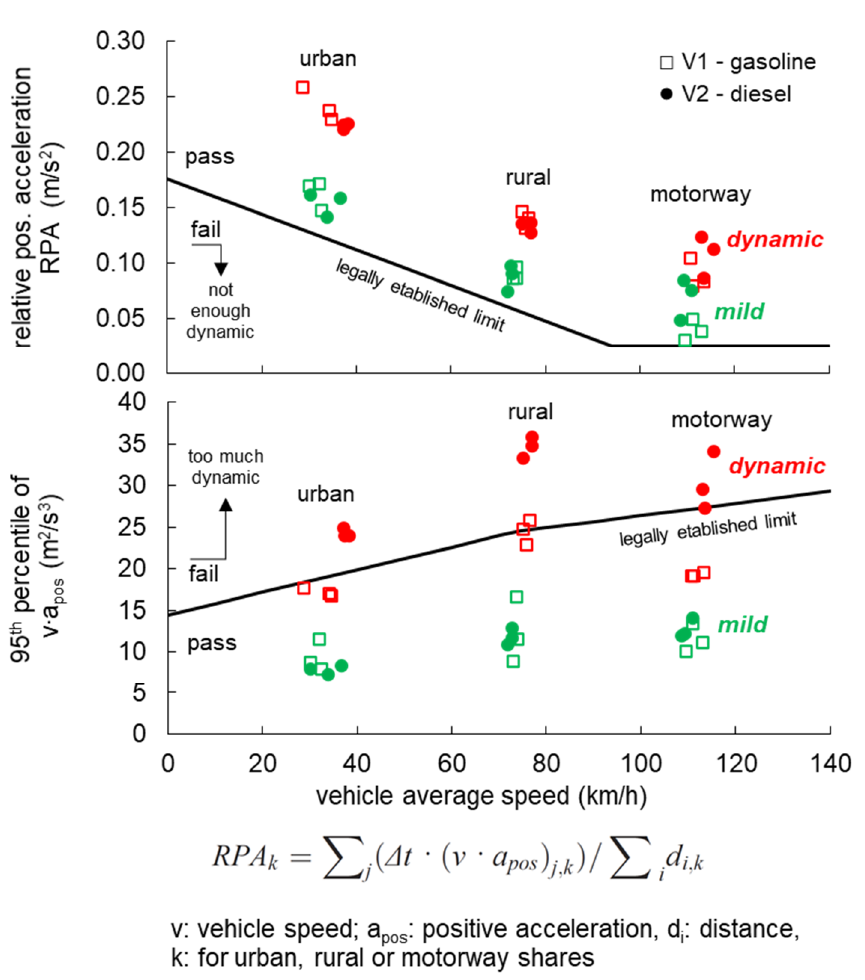
percentile of v × a pos , vehicle 1, gasoline, and vehicle 2, Figure 5. Influences of mild and dynamic driving styles on RDE trip validity for RPA and 95th per- centile of v x a pos , vehicle 1, gasoline, and vehicle 2, diesel.